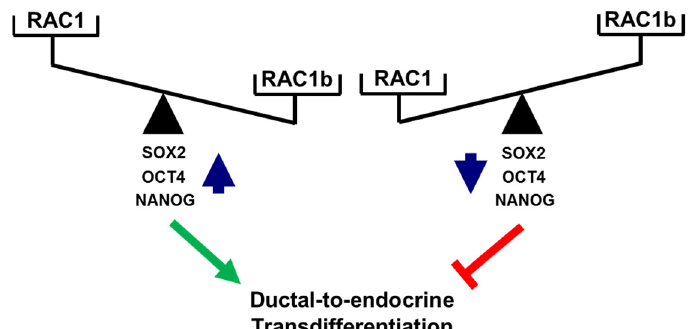
Figure 7. Cartoon illustrating antagonistic regulation of stemness factors and deTD potential in PANC-1 cells. High levels of activated RAC1 (or a high RAC1:RAC1b ratio) promote expression of SOX2, OCT4, and NANOG and favor a deTDtP, while the reverse is true for low levels of activated RAC1 (or a low RAC1:RAC1b ratio). The green arrow and red lines denote stimulatory and inhibitory effects, respectively.